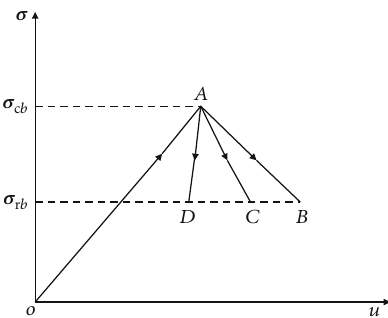
Figure 4: Balance path of coal-rock combination under uniaxial